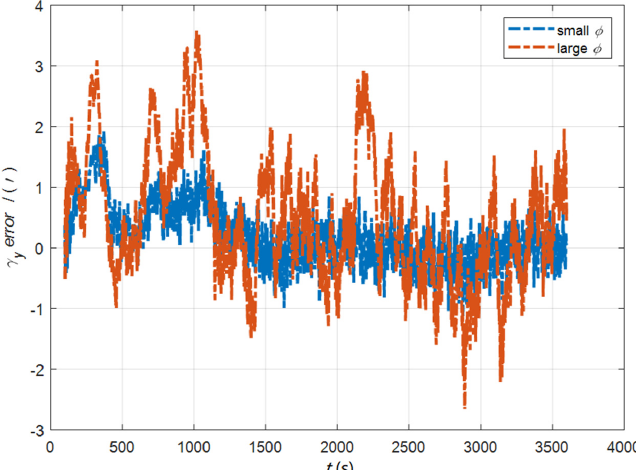
μ γ Table 6. RMSE values of and in the case of the large and small initial misalignment an- gles.